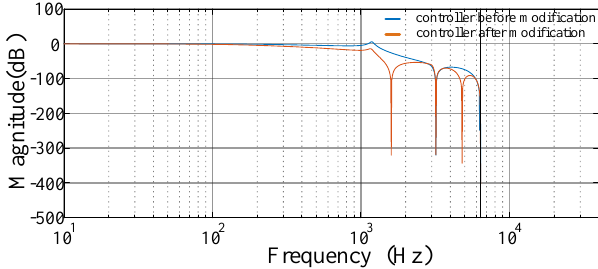
Figure 16. Magnitude-frequency diagram of S(z)P(z) when controller is before or after modification.